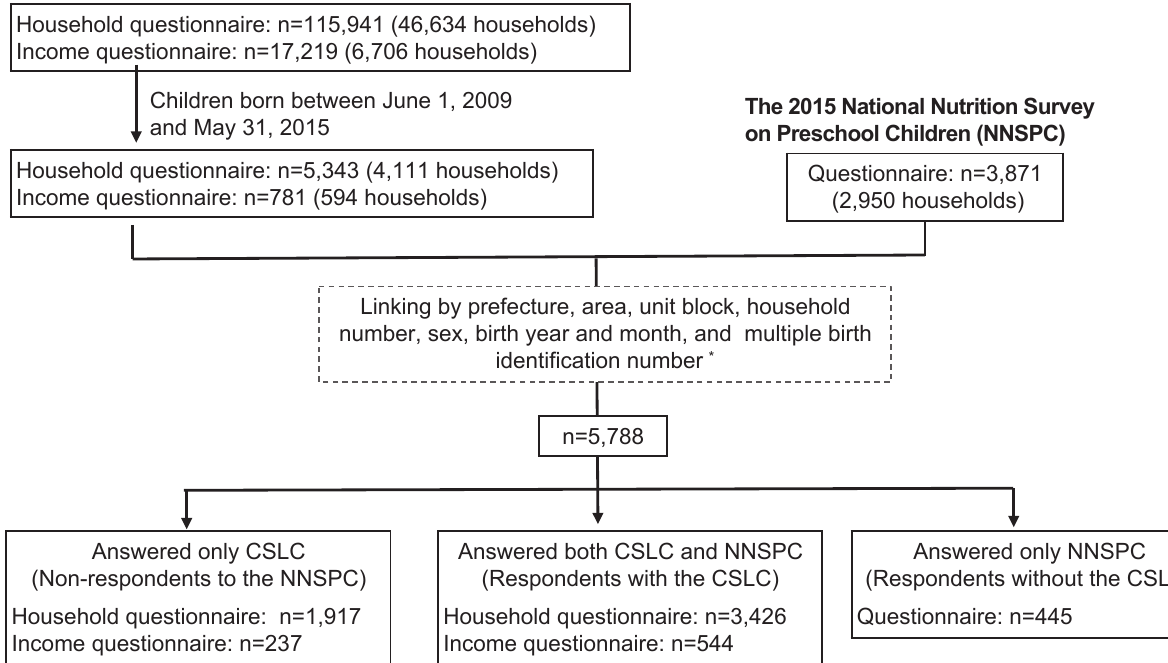
Figure 1. Flow chart of respondents in the 2015 NNSPC. a One of 47 prefectures did not use the same household number in the CSLC and NNSPC. We therefore used information on other variables apart from household number for data linkage as an